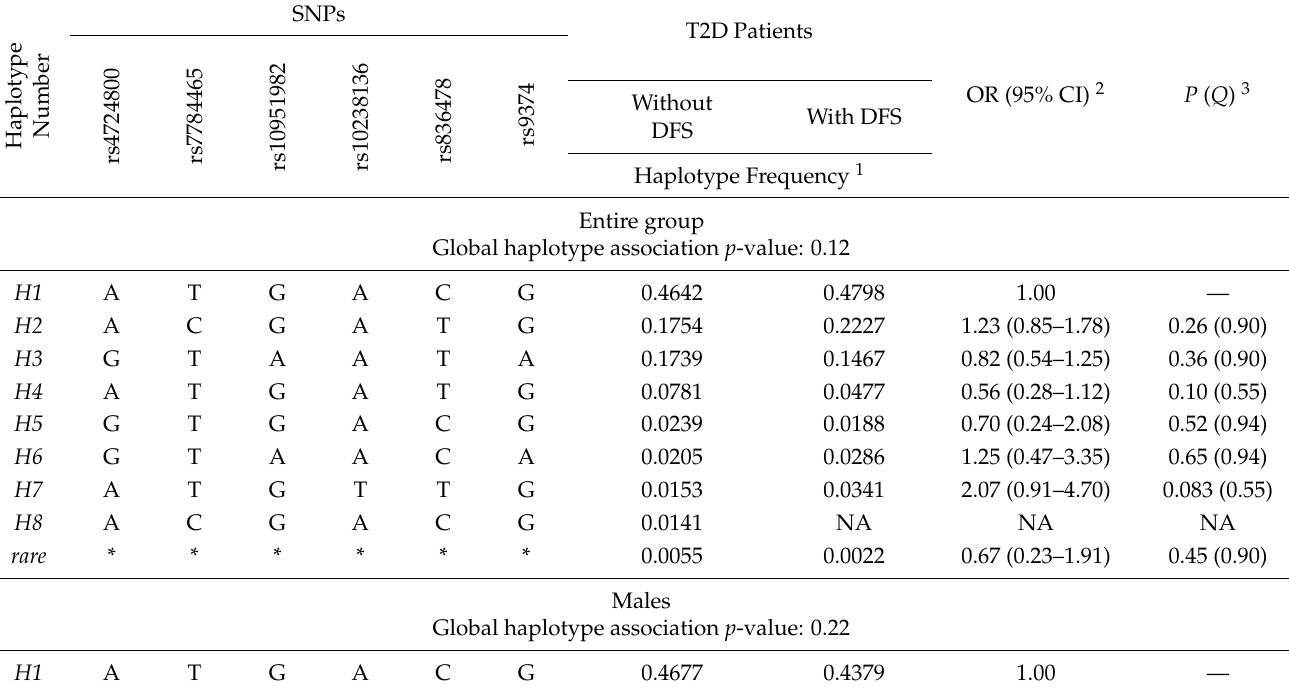
Table 9. Estimated common haplotype frequencies of RAC1 gene in T2D patients with and without diabetic foot